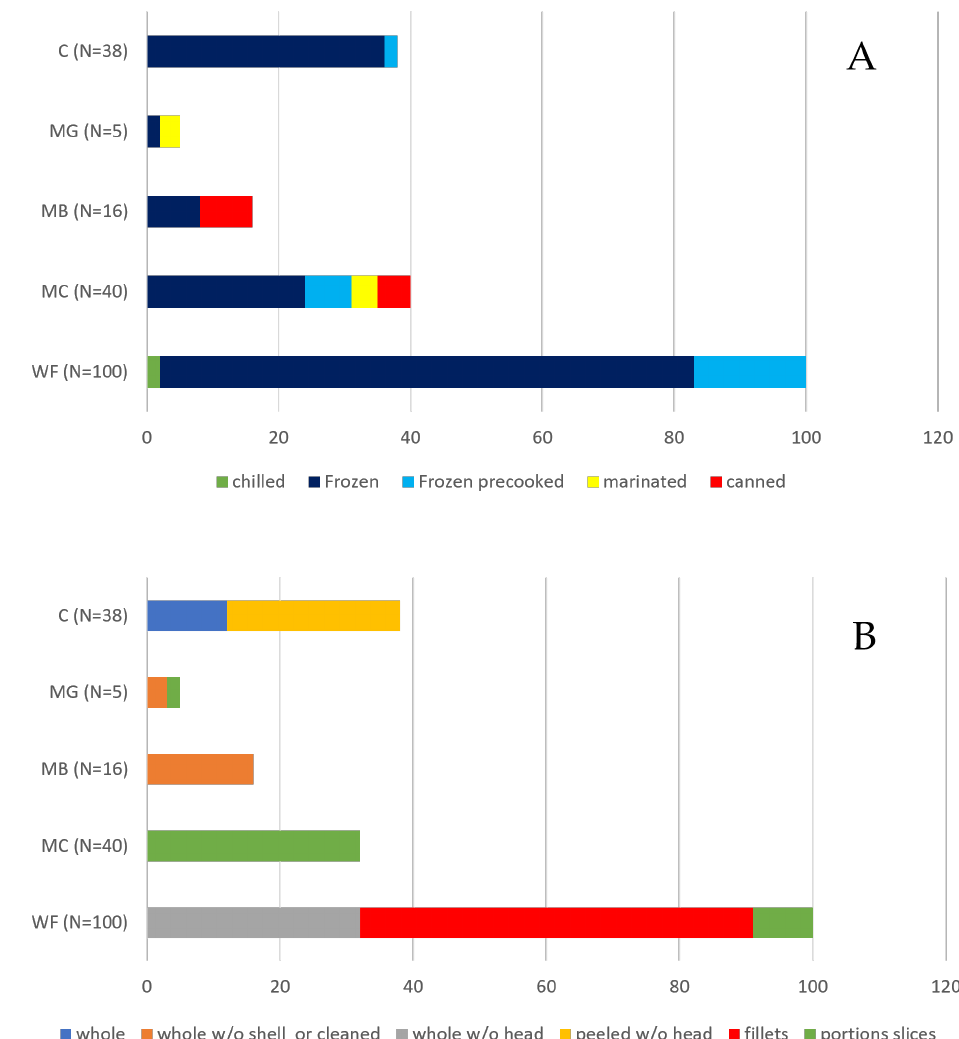
Figure 2. Distribution of product types within the taxonomical classes. (WF—Fish; MC—Mollusks cephalopod mollusks; MB—bivalve mollusks; MG—gastropod mollusks; C—crustaceans. ( A ) Distribution of products types classified according to Regulation (EC) No. 852/2004 [29]. ( B ) distribution of product types classified according to the type of presentation for sale (without previous preparation, post evisceration, post cutting)